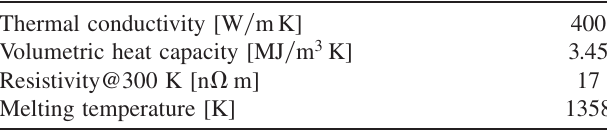
TABLE II. Fundamental constants for